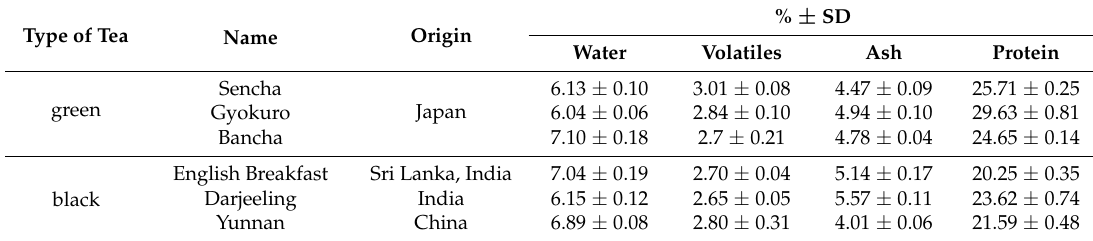
Table 1. Characteristics of the tea selected for analysis. SD: standard